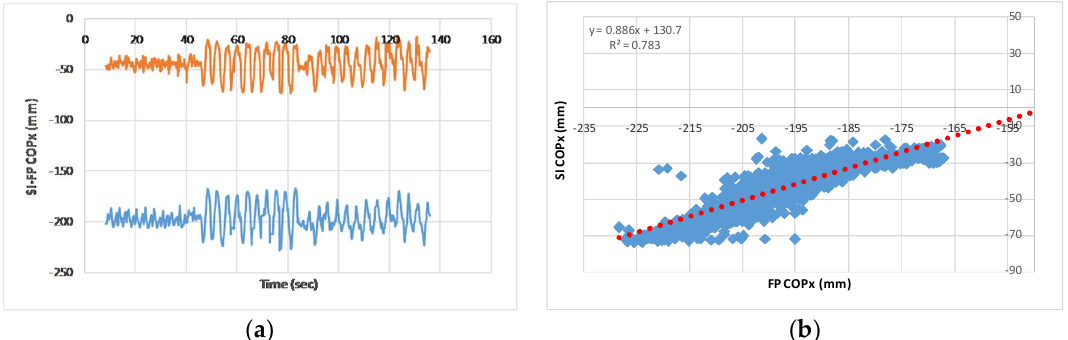
Figure 4. ( a ) COPx of SI (orange) and FP (blue) against time (one participant); ( b ) l inear regression fit function for COPx (mm) FP vs COPx (mm) SI (one